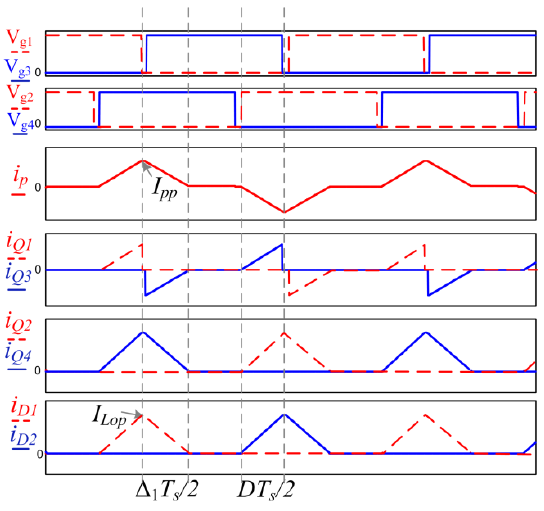
Figure 8. Key waveforms of the PSFB converter in DCM